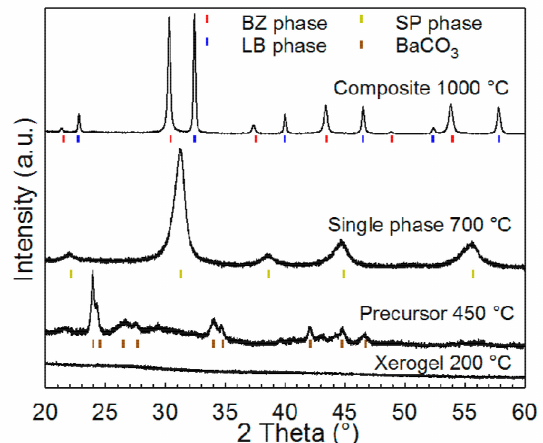
Figure 1. Tracking of the synthesis of 3M10Y by X-ray diffraction at room temperature after each synthesis step. This synthesis is representative for all the compositions of the 3 M family. The exsolution of the single phase into the composite was done at 1000 ◦ C. BZ, LB, and SP stand for barium zirconate-based phase BaZr 1 − z Y z O 3 − δ , lanthanum metal oxide-based phase La 0.5 Ba 0.5 Co 1/3 Mn 1/3 Fe 1/3 O 3 − δ , and single phase